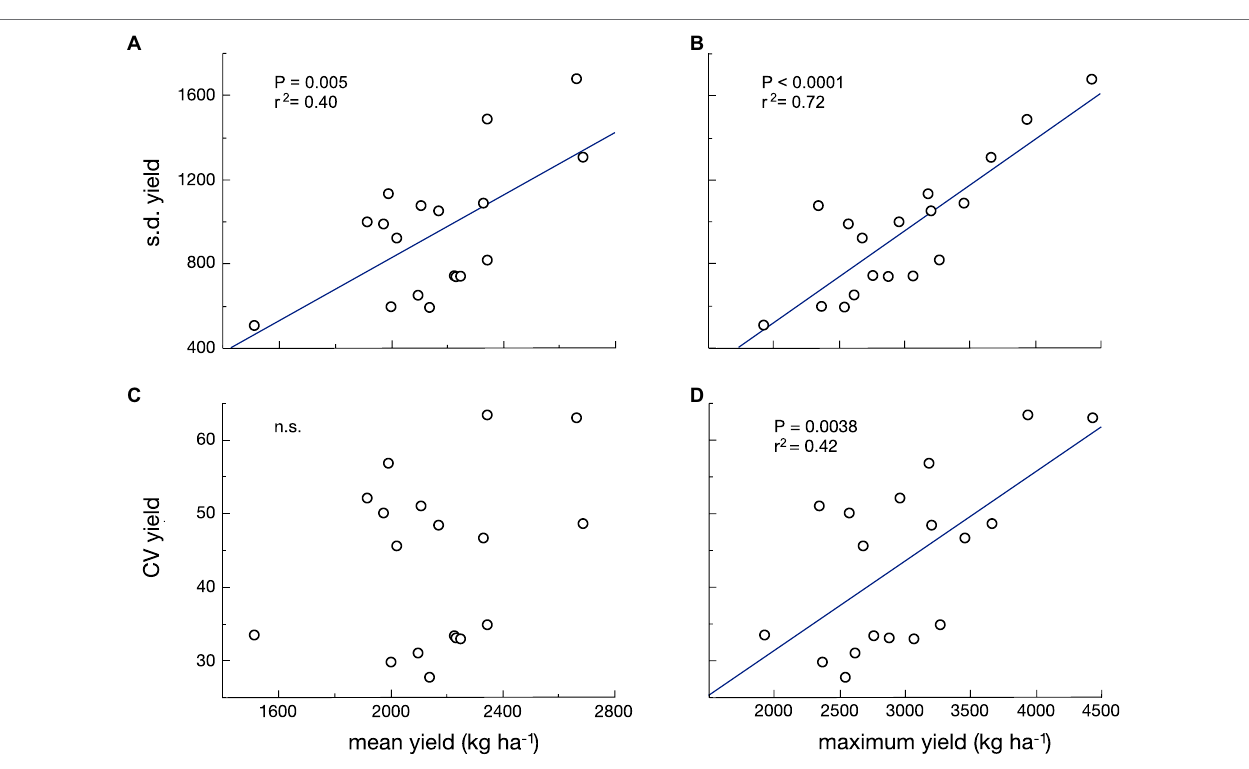
FIGURE 2 | The standard deviation (s.d.; A,B ) and the coefficient of variation (CV; C,D ) of yield vs. mean yield (A,C) and vs. maximum yield (B,D) for 18 cultivars of wheat grown in three environments. The relationships with the highest yield are stronger and more significant than those with mean yield [Data from Du et al.